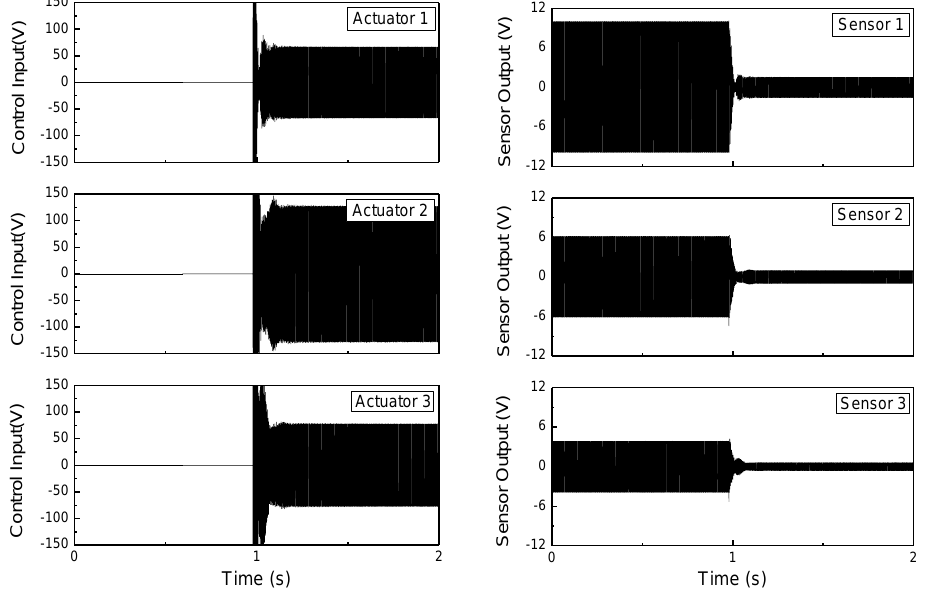
Figure 11. Actuator input voltages and control response under 3rd mode